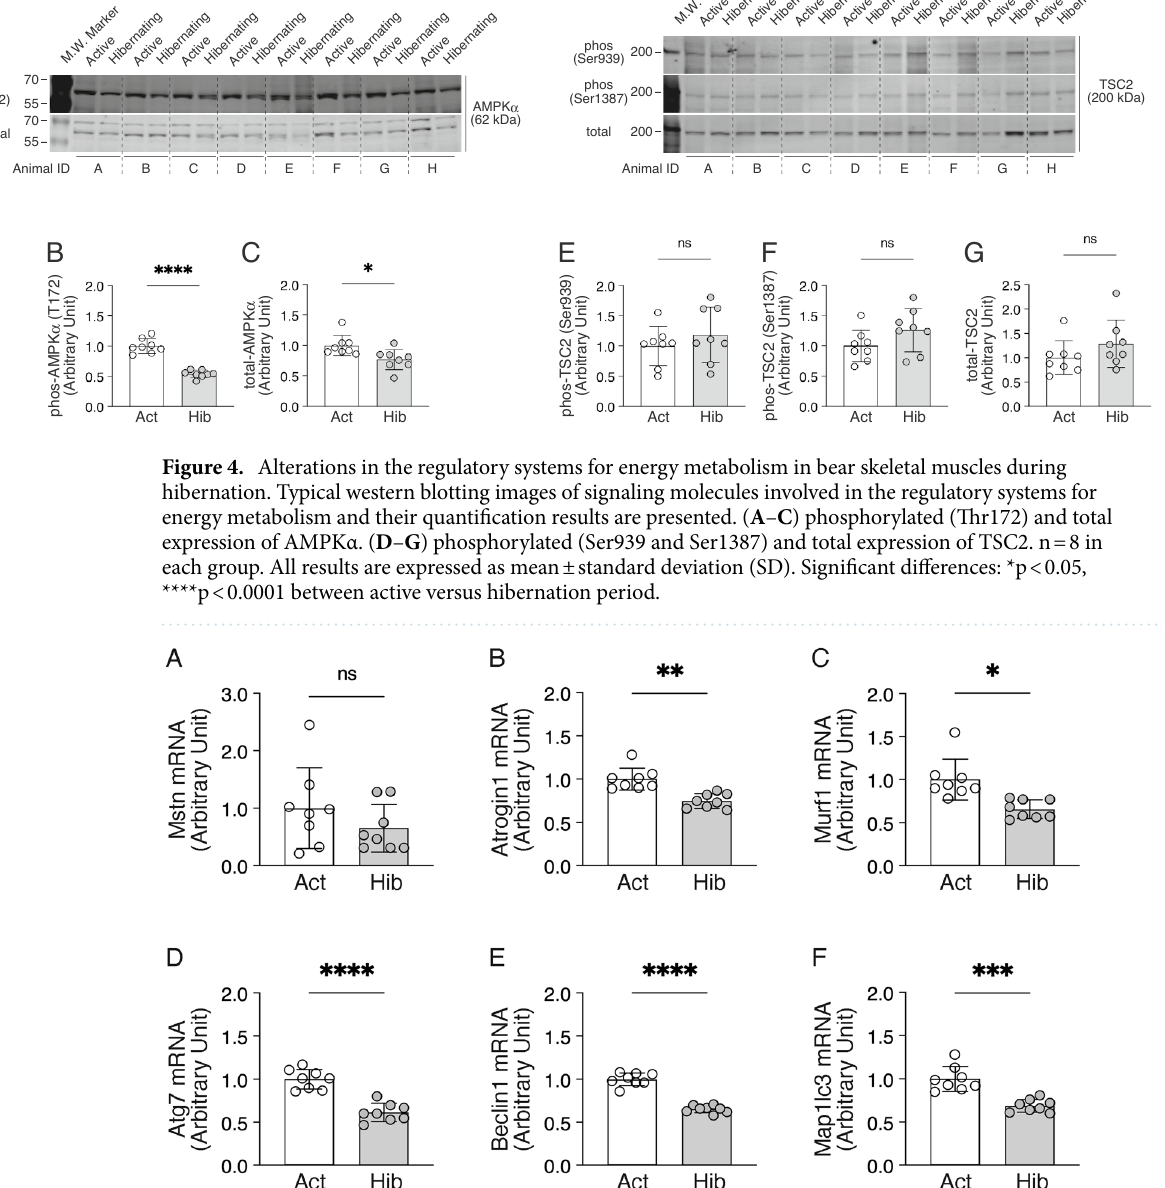
Figure 5. Gene expression of the regulatory systems for muscle protein catabolism during hibernation in bears. Gene expression levels of the myostatin ( A ), ubiquitin–proteasome system (atrogin1 and murf1) ( B , C ) and autophagy-lysosome system (atg7, beclin1, and map1lc3) ( D – F ) were quantified by real-time PCR. Ribosomal protein L26 was used as an internal control for the 2 –ΔΔCT method. n = 8 in each group. Data are expressed as mean ± standard deviation (SD). Significant differences: *p < 0.05, **p < 0.01, ***p < 0.001, ****p < 0.0001 between Active versus Hibernation